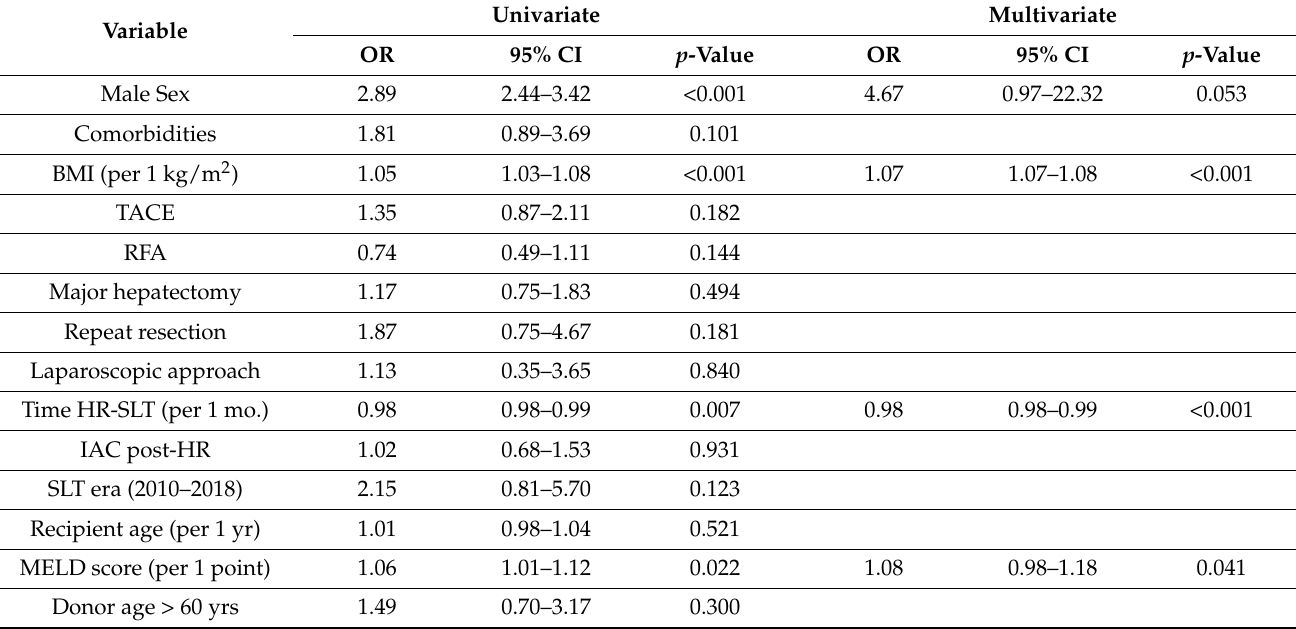
Table 4. Uni-and multivariate analysis of predictors of severe complications after SLT (Comprehensive Complication Index ≥ 29.6).